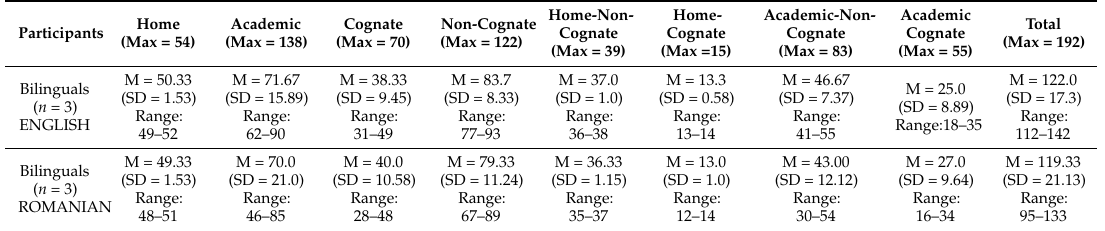
Table 3. Mean raw scores of the bilingual children in Romanian and English at T5 (age six).